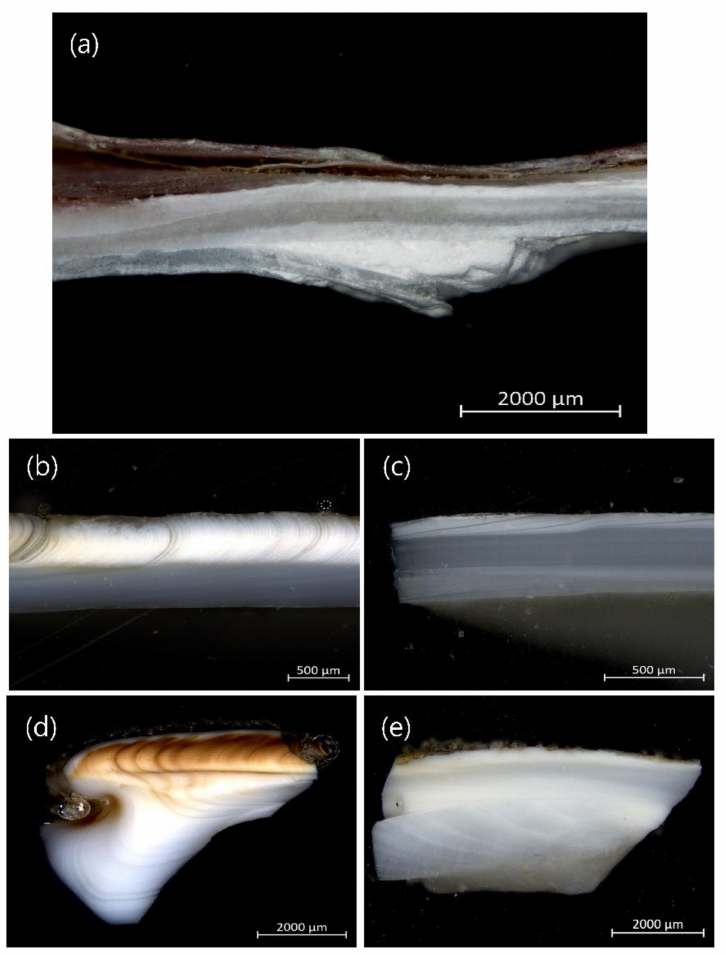
Figure 11. Optical images of cross-sectional sample: ( a ) CR-A. ( b ) CR-B. ( c ) CR-C. ( d ) CR-D. ( e )